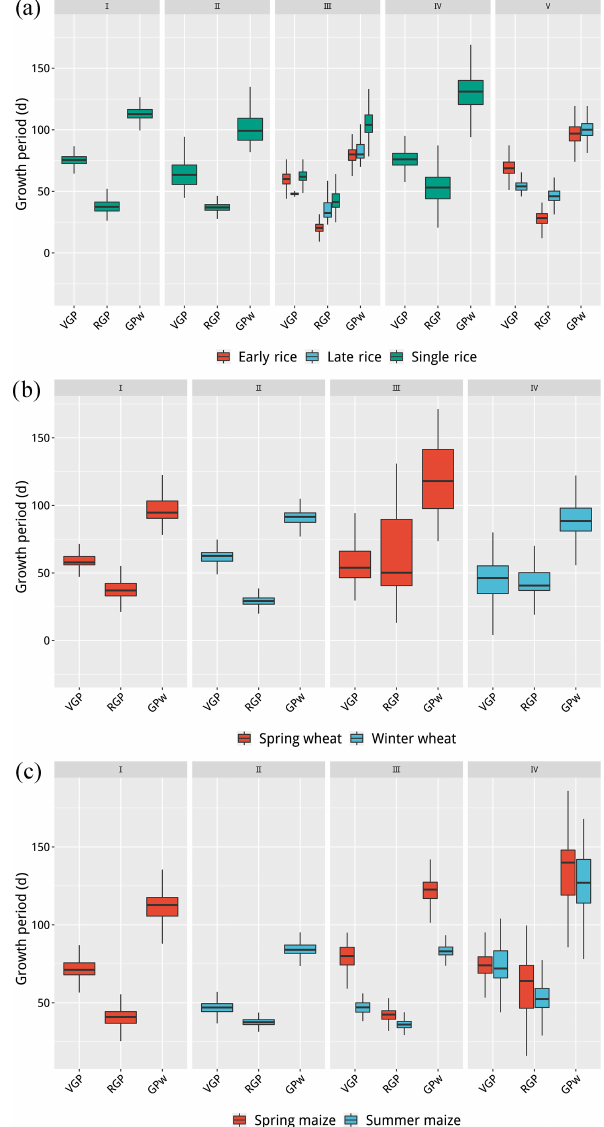
Figure 8. Box plots of three key phenological periods by crop and subregions during 2000–2015, for vegetative growth period (VGP); reproductive growth period (VGP); and whole growth pe- riod (GPW) of rice (a) , wheat (b) and maize (c)